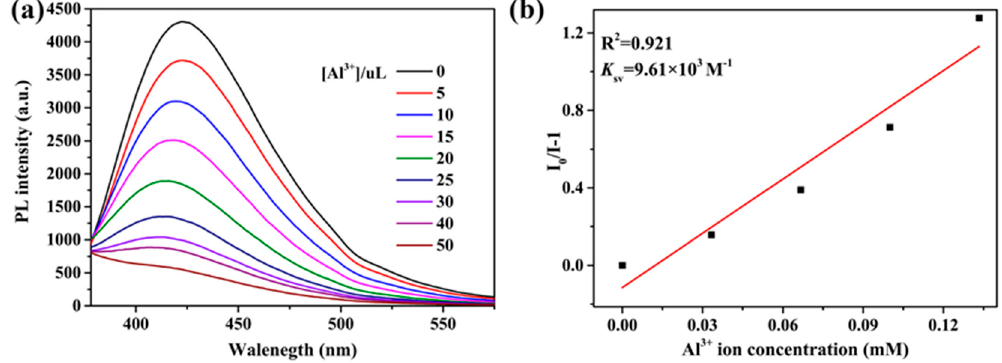
Figure 8. ( a ) Luminescence intensities of 2 in different concentrations of Al 3+ ions. ( b ) Linear relation between Al 3+ ions and I / I 0 − 1.